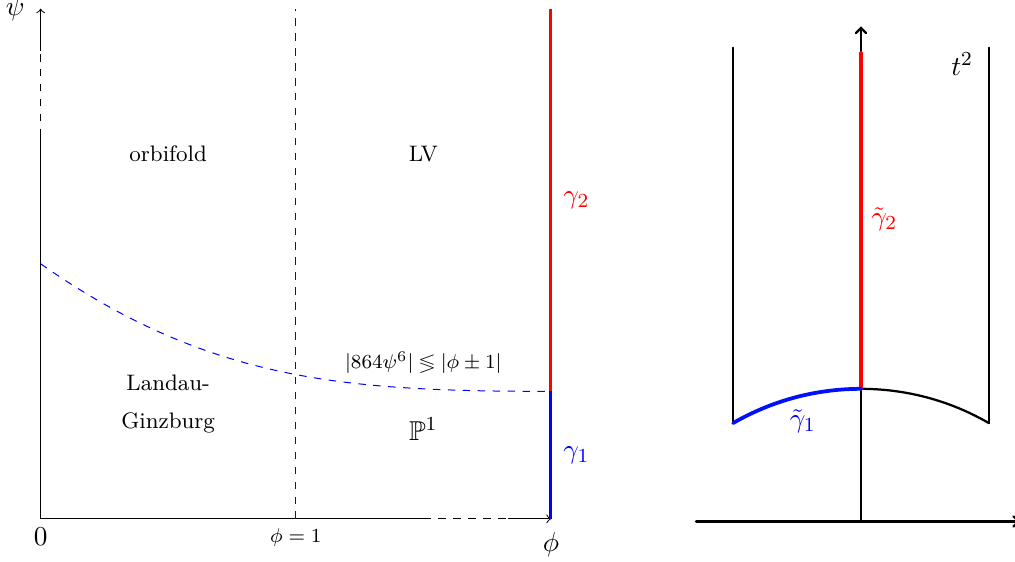
Figure 4 . Mapping of type II and heterotic moduli spaces in the weak coupling